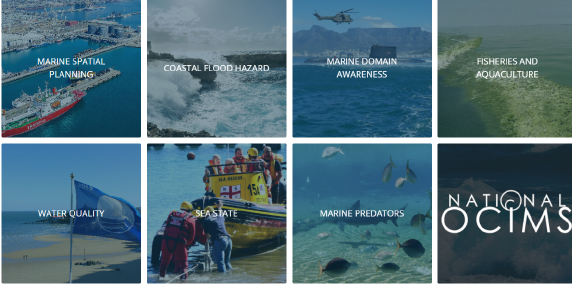
Figure 1. The National Oceans and Coastal Information Management System (OCIMS) tools and services